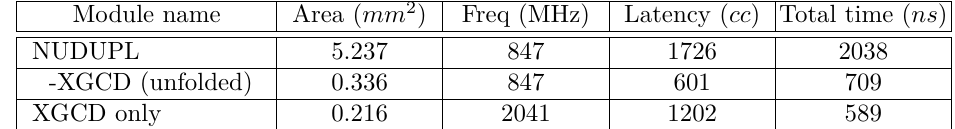
Table 6: Implementation results of the proposed NUDUPL architecture and XGCD architecture on TSMC 28-nm CMOS